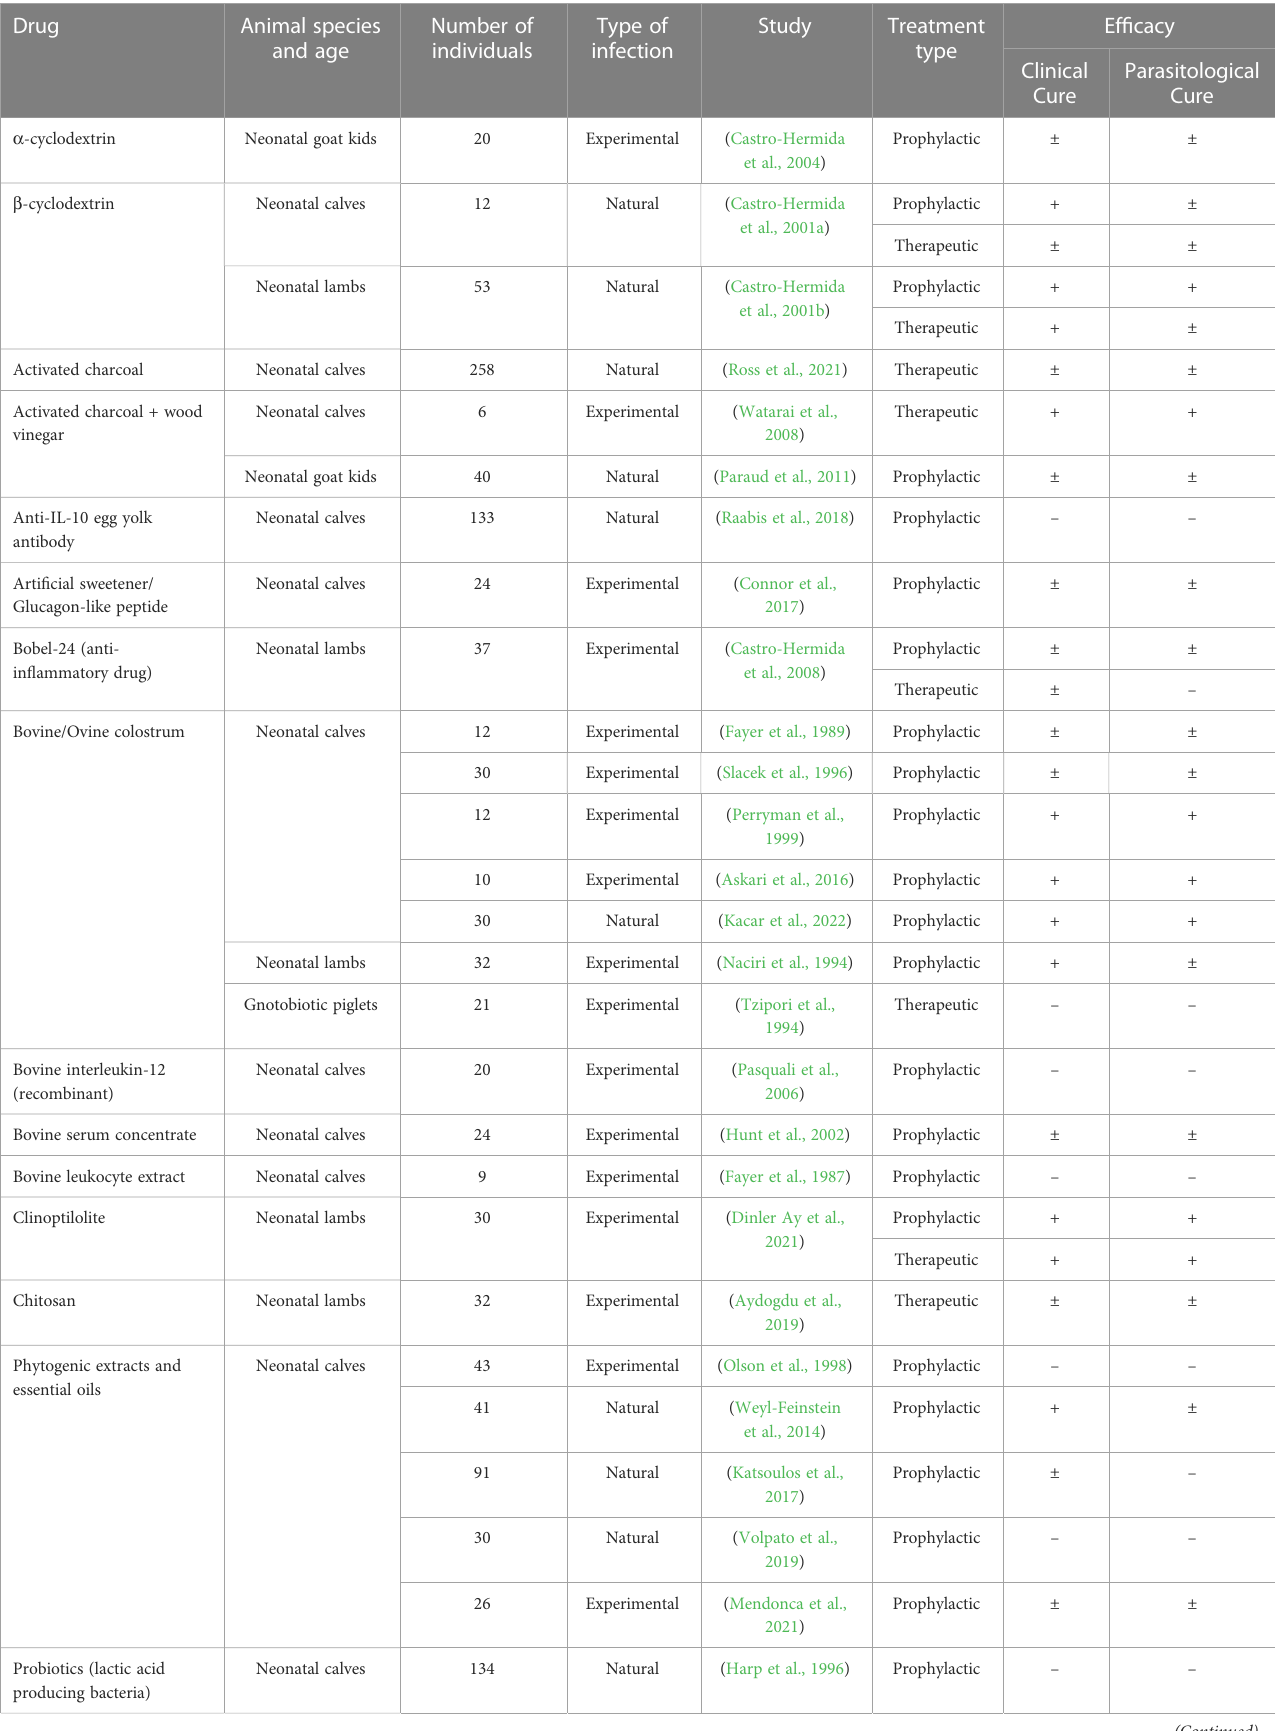
TABLE 5 Alternate treatments tested for ef fi cacy against cryptosporidiosis in farm animals and natural host animal